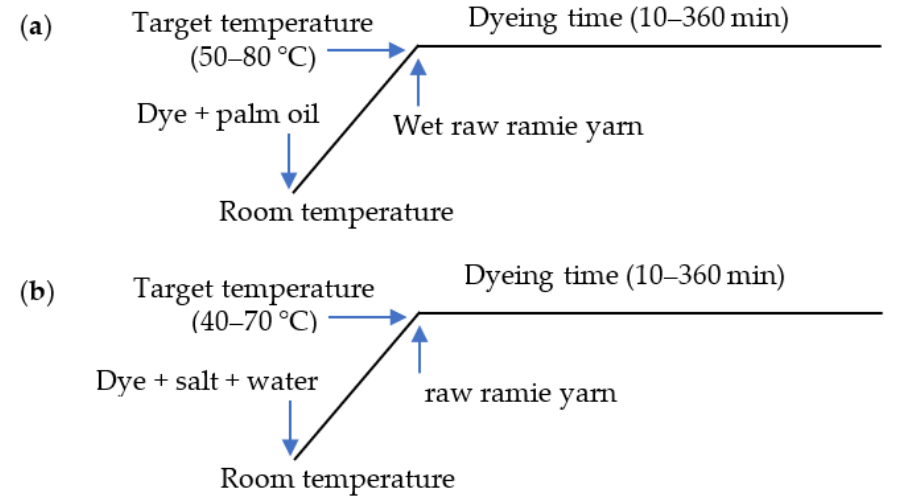
Figure 3. Dyeing profile of raw ramie yarn with Reactive Blue 194 in ( a ) palm oil and ( b ) water media.